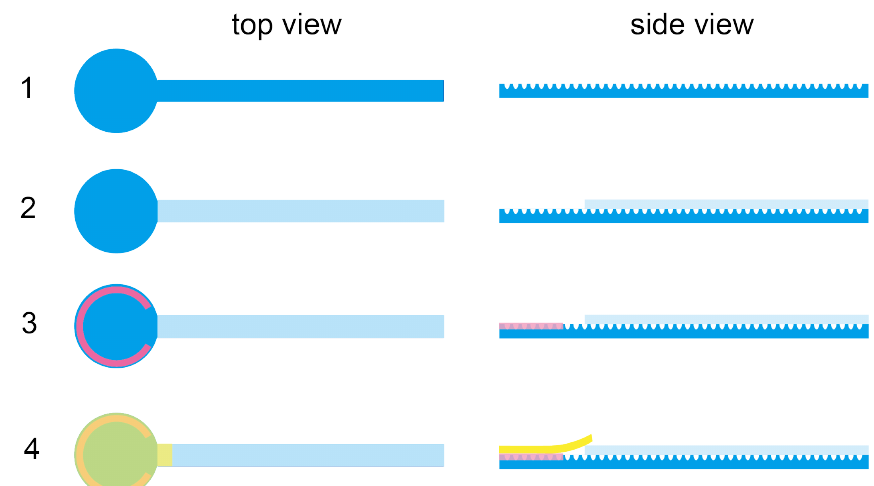
Figure A2. Assembly of the microfluidic device. The picture on the left shows the assembly steps from the top view, and the picture on the right shows the assembly steps from the side